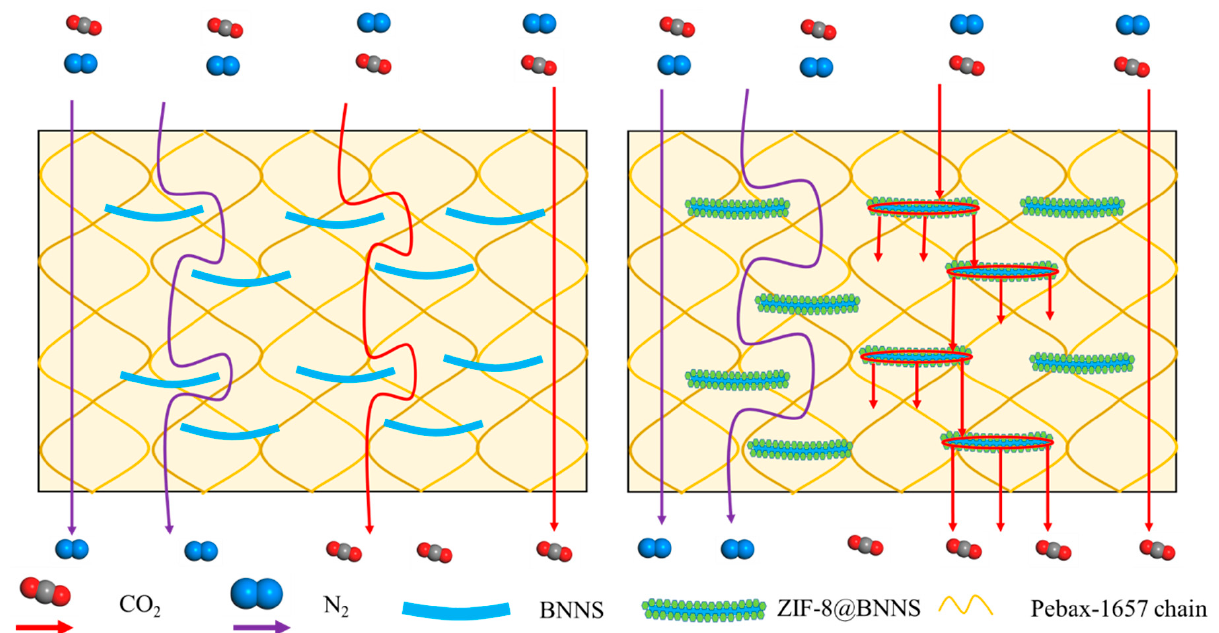
Figure 8. Comparison in mass transfer pathways for MMMs containing BNNS and ZIF-8@BNNS.